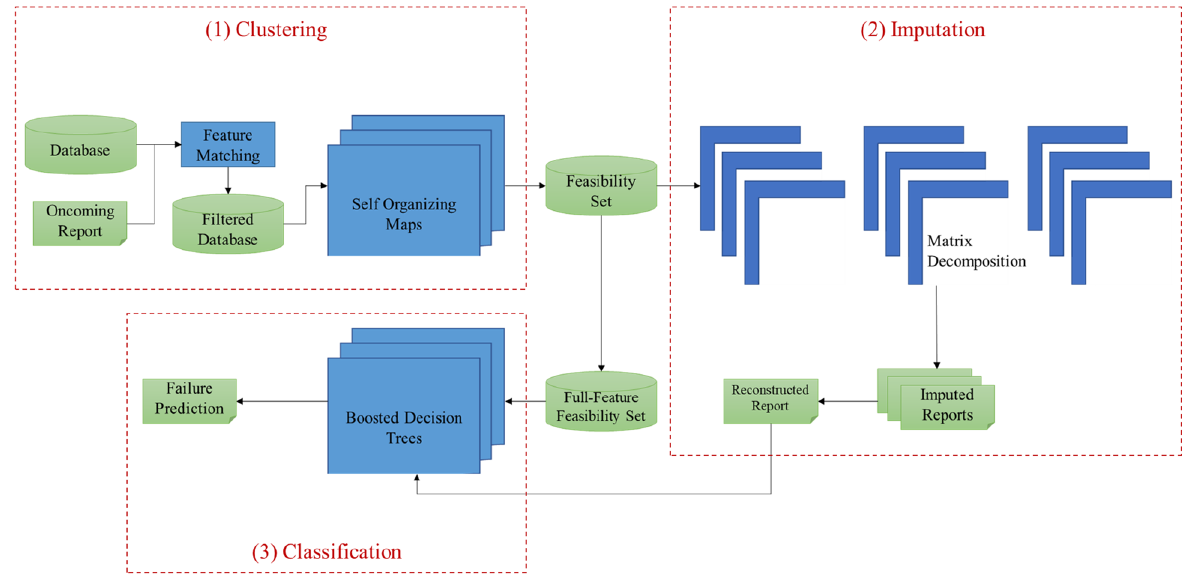
Figure 1. Proposed CIC framework for detecting pipeline failure events. The ensemble based semi-supervised approach is divided into: (1) Clustering, (2) Data Imputation, and (3) Classification. The separability between the three CIC stages allows for a more adaptive application and easier tuning of the models’